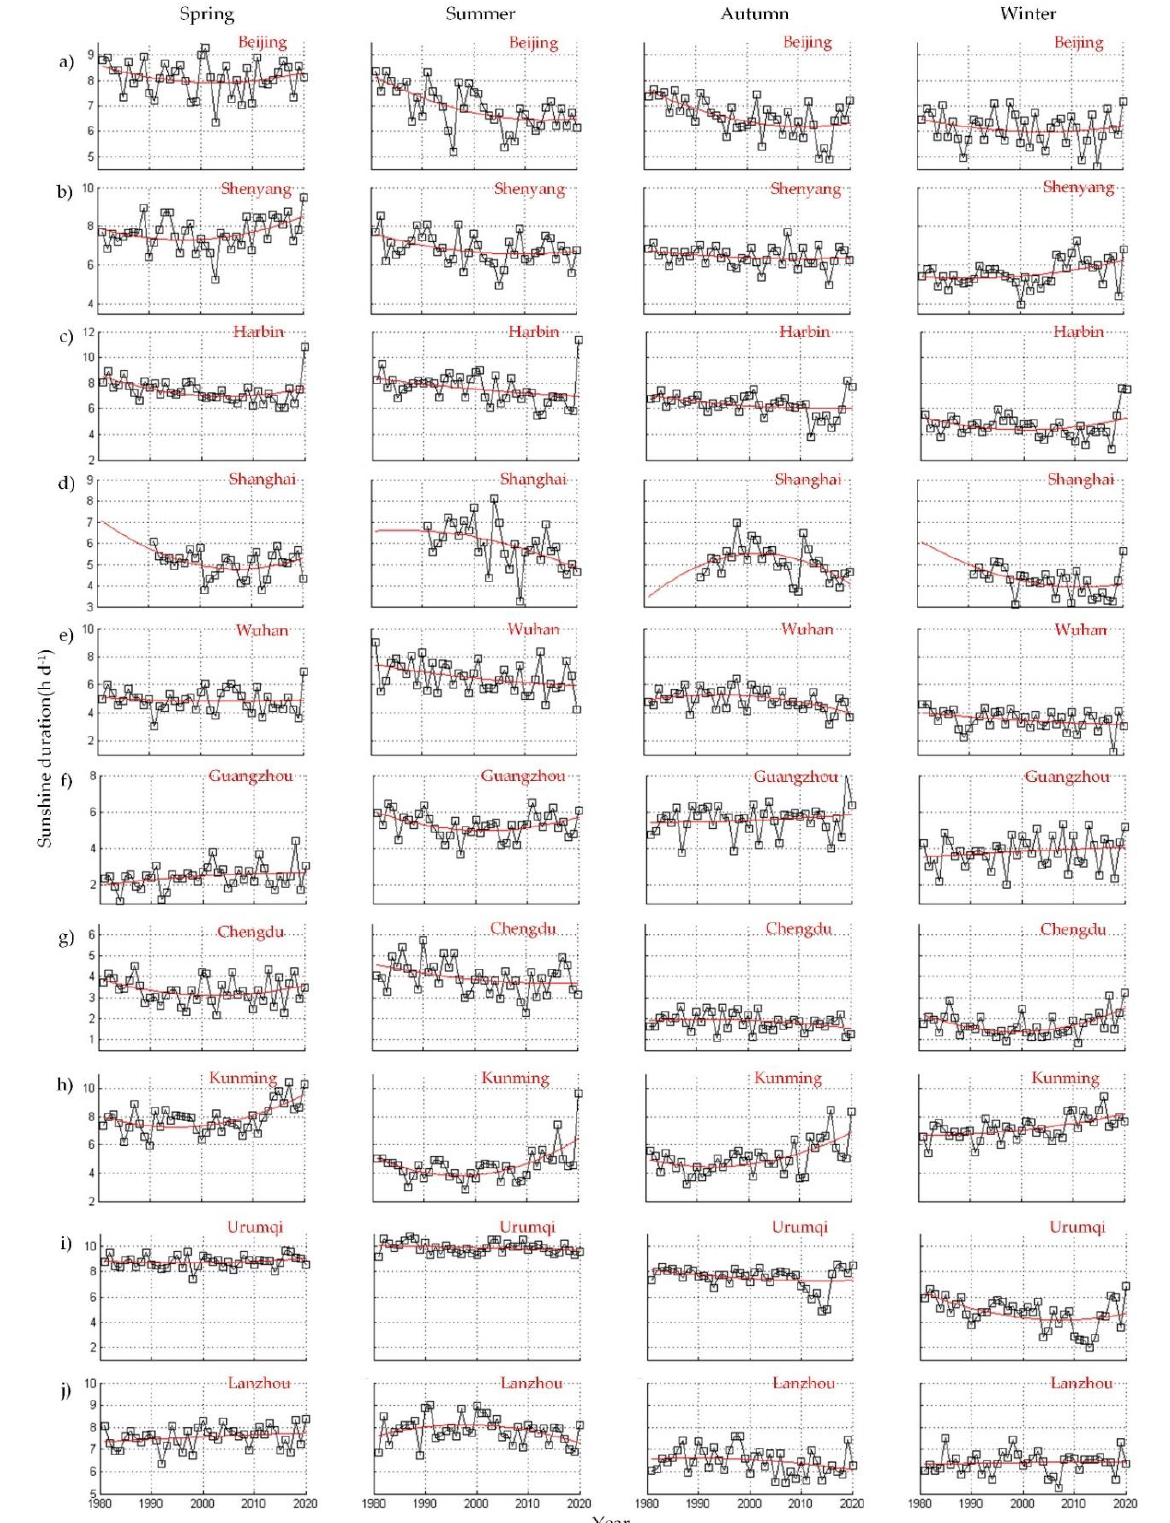
Figure 4. Seasonal trends in SD from 1981 to 2020 for the ten selected stations. ( a ) Seasonal trends in SD for Beijing; ( b ) Seasonal trends in SD for Shenyang; ( c ) Seasonal trends in SD for Harbin; ( d ) Seasonal trends in SD for Shanghai; ( e ) Seasonal trends in SD for Wuhan; ( f ) Seasonal trends in SD for Guangzhou; ( g ) Seasonal trends in SD for Chengdu; ( h ) Seasonal trends in SD for Kunming; ( i ) Seasonal trends in SD for Urumqi; ( j ) Seasonal trends in SD for Lanzhou.